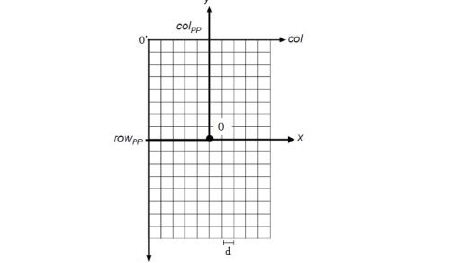
Figure 2. Image plane coordinate system and pixel coordinate